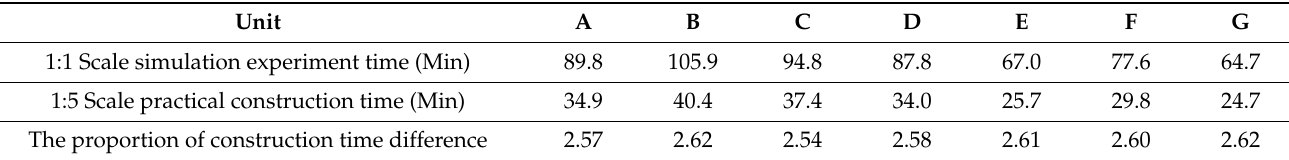
Table 1. The proportional construction time difference between the simulation experiment and the practical